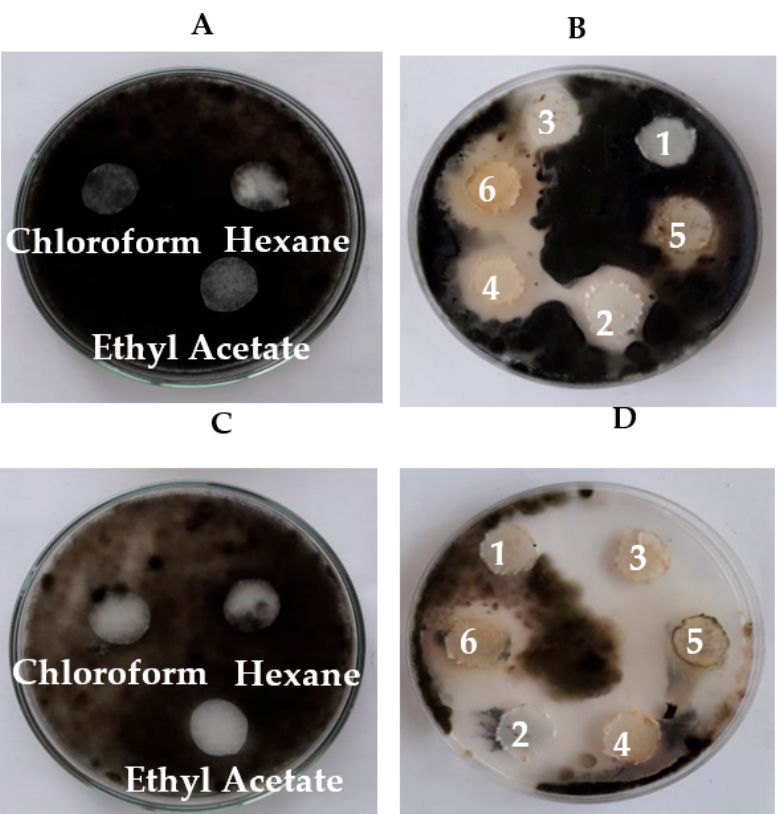
Figure 7. Bioassay activity using the filter paper diffusion method of the antifungal compounds extracted by different types of solvents from B. amyloliquefaciens and B. velezensis using Alternaria sp. and Helminthosporium sp. as test microorganisms. ( A , C ) represent the effect of different solvents (50 µ L) on Helminthosporium sp. and Alternaria sp., respectively (control). ( B , D ) represent the effect of solvent extracts of B. amyloliquefaciens and B. velezensis (50 µ L) on Helminthosporium sp. and Alternaria sp., respectively. ( 1 ) B. velezensis methanol Chloroform extract ( 2 ) B. amyloliquefaciens ethyl acetate extract ( 3 ) B. velezensis ethyl acetate extract ( 4 ) B. amyloliquefaciens methanol and chloroform extract. Hexane extracts of B. velezensis ( 5 ) and B. amyloliquefaciens ( 6